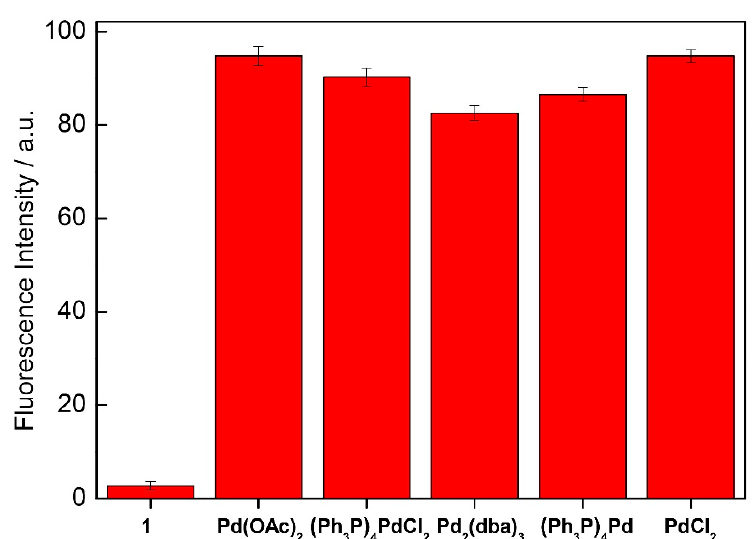
Figure 3. Comparison of the fluorescence change depending on different palladium complexes, measured for an equimolar mixture of chemosensor 1 (1.0 μ M) and the palladium species in H 2 O:DMF (9:1) containing HEPES bu ff er (10 mM, pH 7.4). ( λ ex = 330 nm).